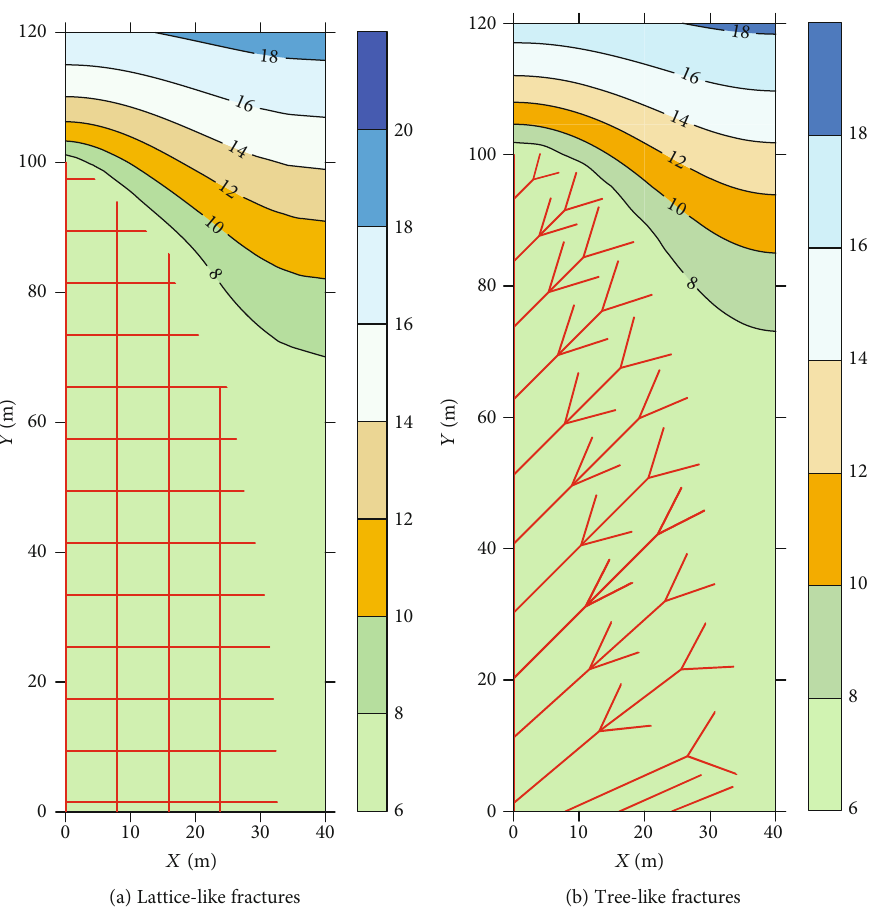
Figure 6: Pressure distribution contour map after 600 days (unit: MPa).